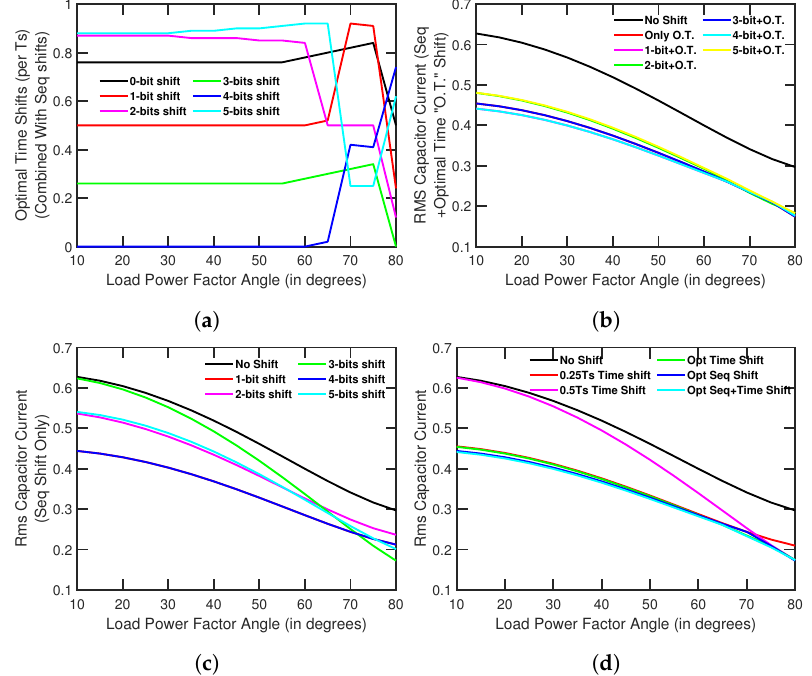
Figure 10. For equal load and mod.index = 0.5. ( a ) Optimal time shifts (combined with seq shifts). ( b ) i c,rms for seq+opt time shifts. ( c ) i c,rms for only seq shifts. ( d ) Comparative i c,rms for different interleaving shifts.